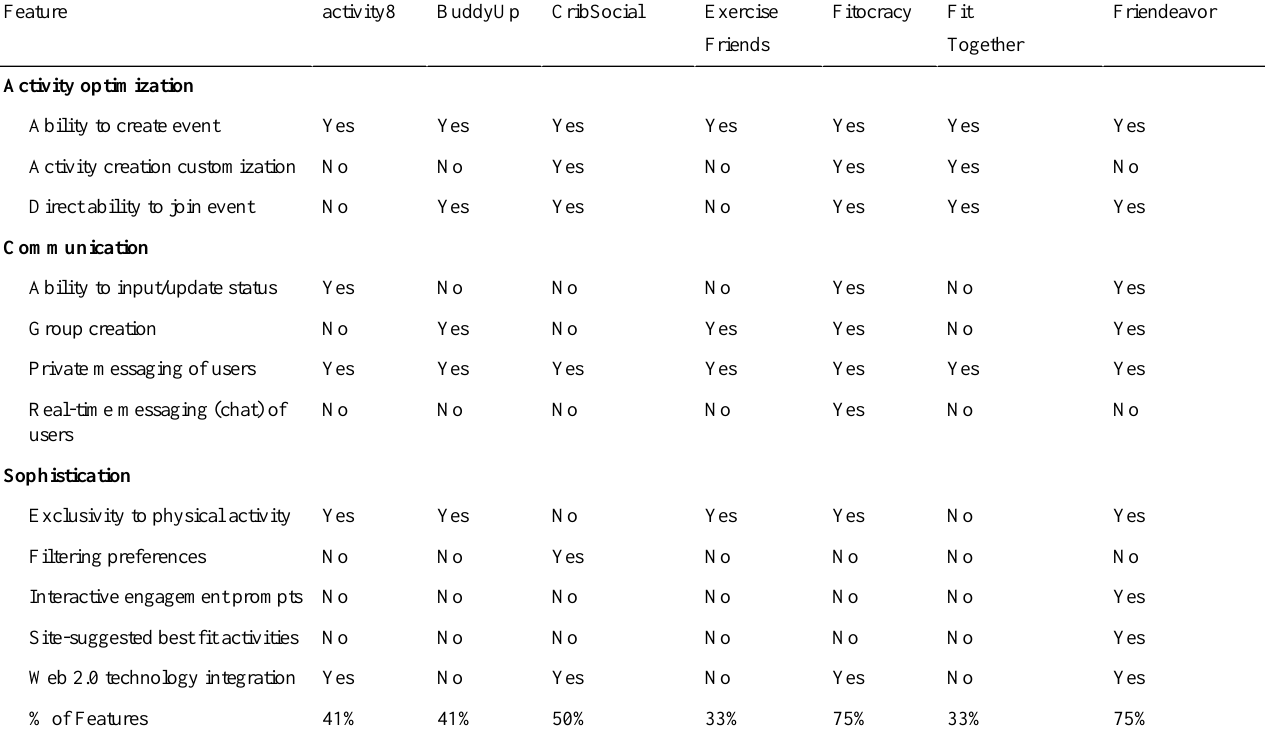
Table 4. Features of online social networks that connect users to physical activity partners